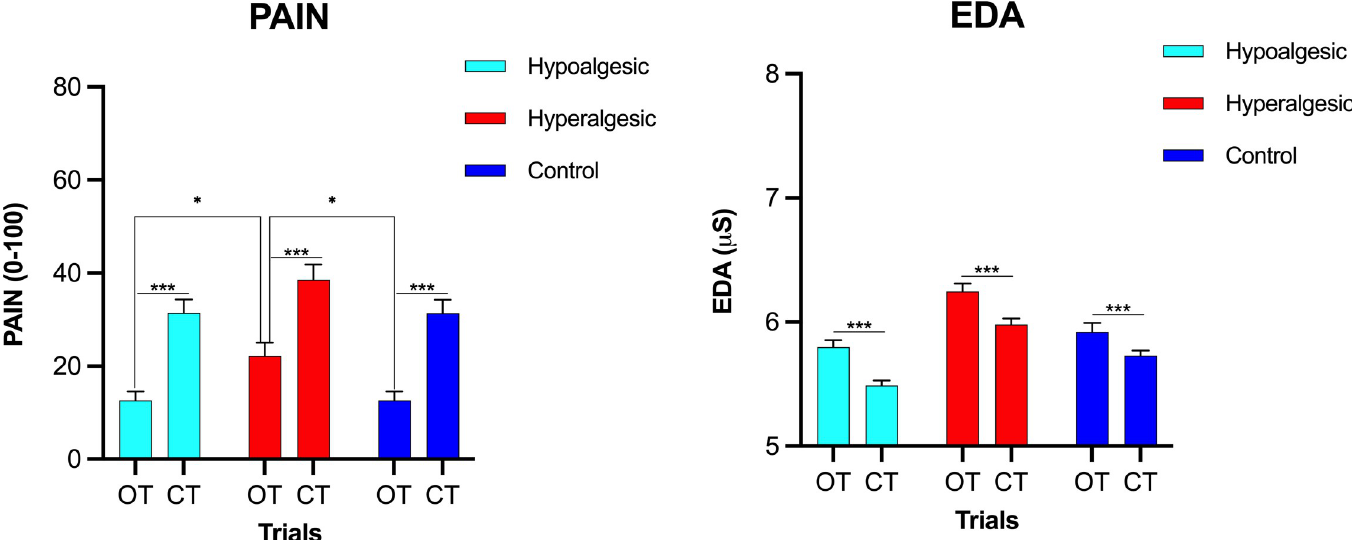
Fig 3. Within- and between-group effects for pain assessed via a computerized visual analog scale (COVAS, left) and electrodermal activity (EDA, right). Offset analgesia was reduced in the hyperalgesic group as reflected by a less pronounced difference in pain (averaged of 25-34s interval) between offset trials (OT) and constant trials (CT). Upper comparisons denote between-group comparisons: The hyperalgesic group experienced more pain than the control and hypoalgesic groups. Lower comparisons denote within-group comparisons for OT and CT. Error bars represent standard errors of the mean (SEM), � indicates a significant difference at p < 0.05, ��� p < 0.001.